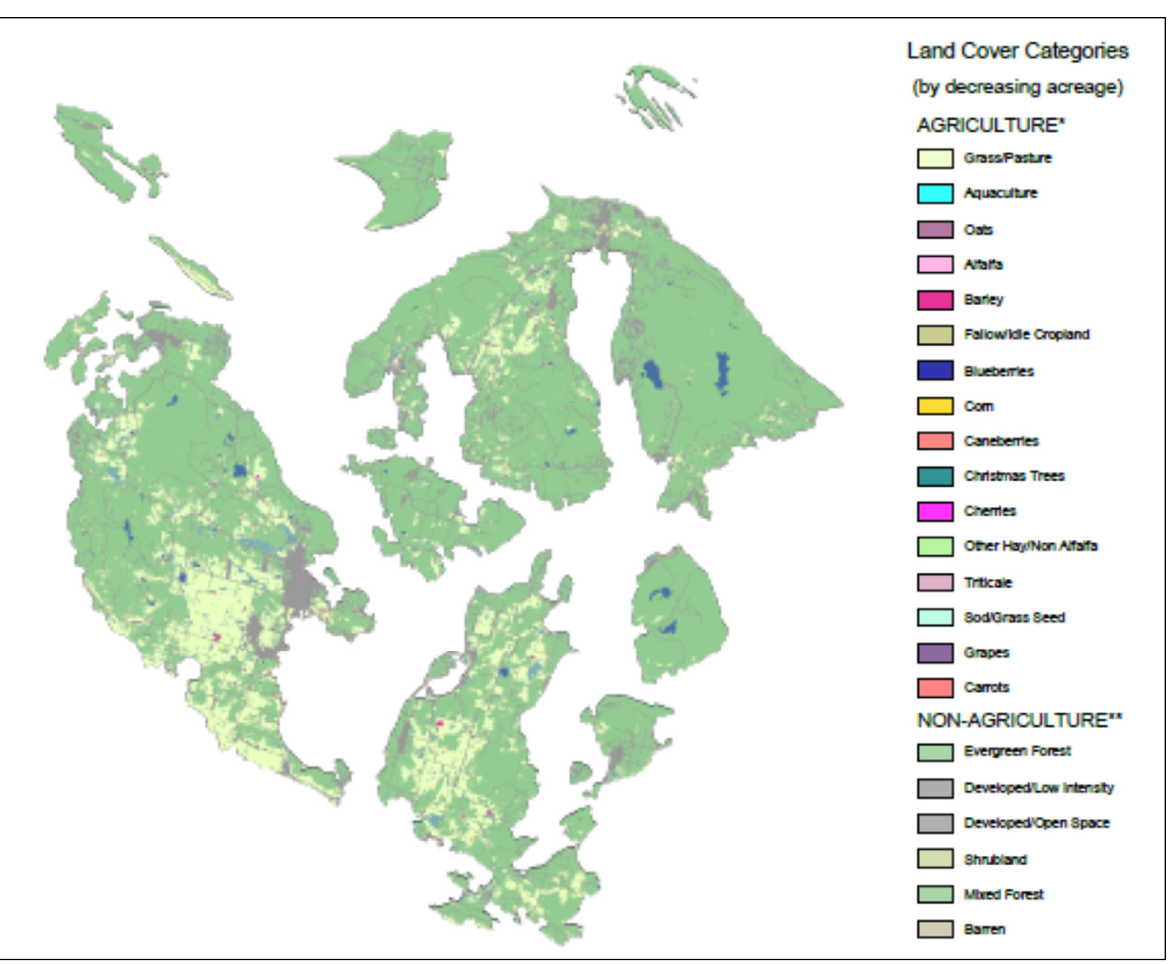
Figure 1. San Juan County, Washington, Cropland Data Layer,